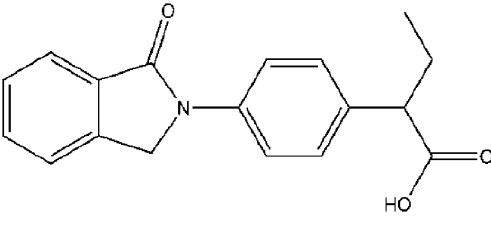
Figure 1. The chemical structure of indobufen.